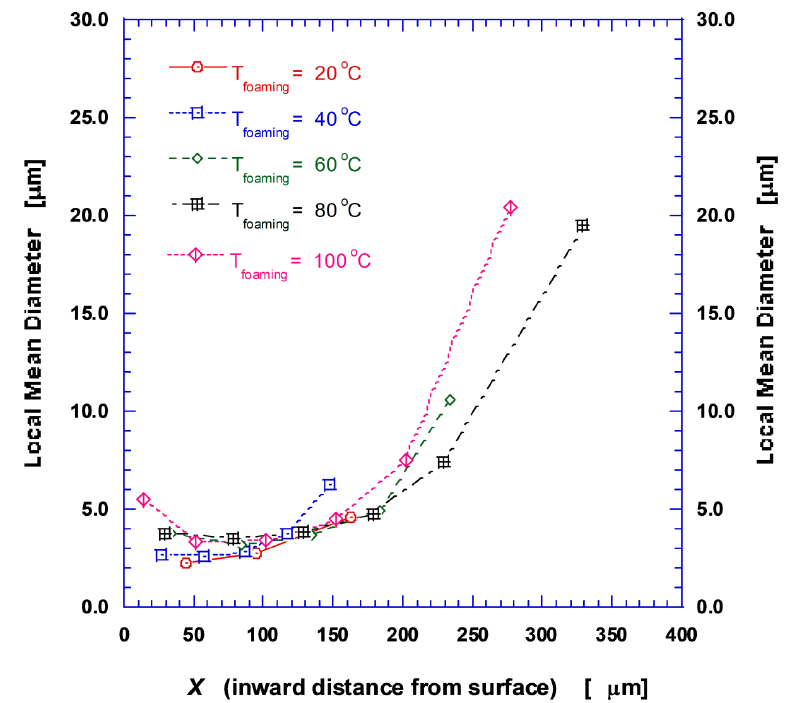
Figure 2. Variation of local foam diameter along radial direction as trend of gradient foaming depending on post-foaming temperature. x = 0 corresponds to the outer surface location of PET–PEN copolymer